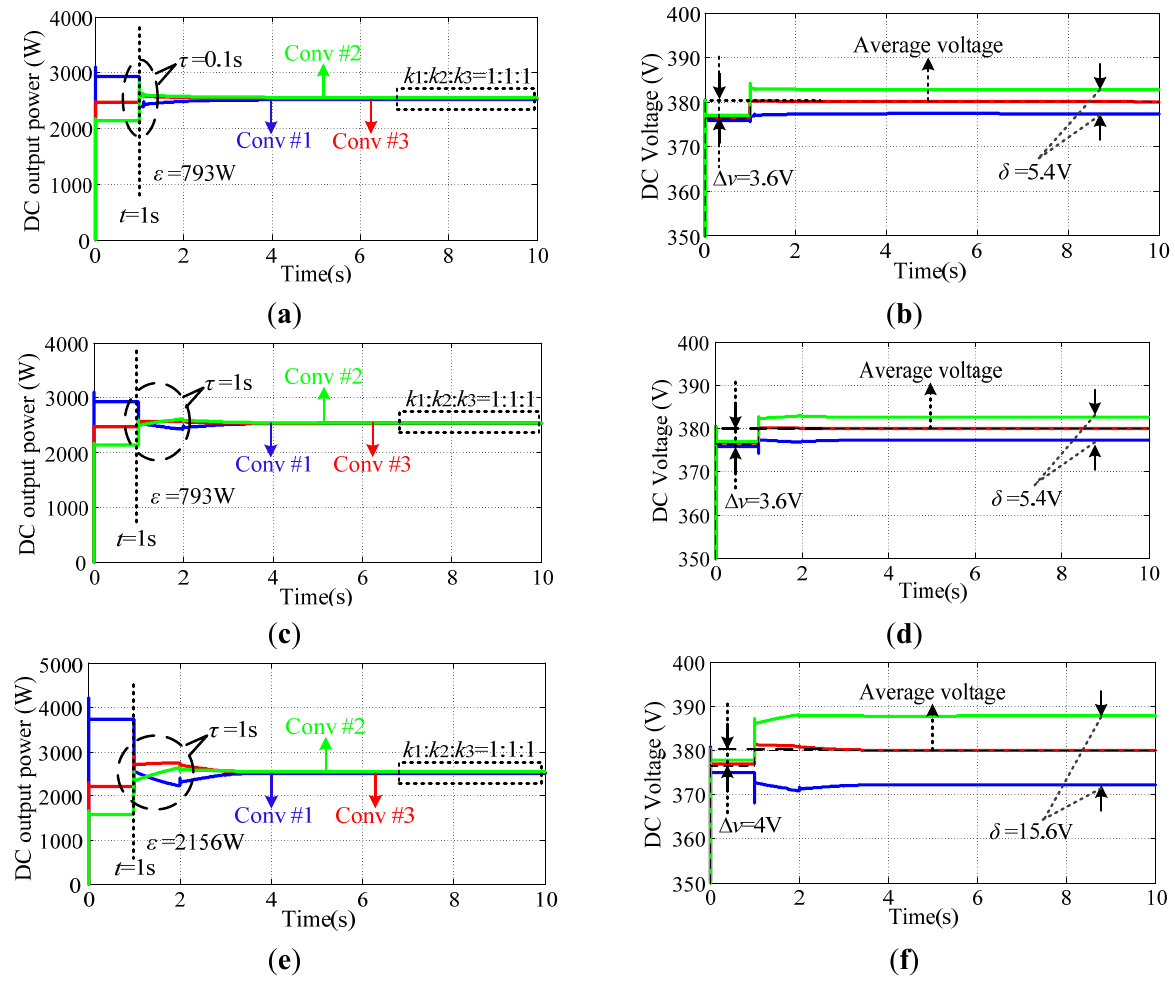
Figure 7. Transient responses for radial configuration in the DC microgrid. ( a ) Case 4, Power sharing accuracy; ( b ) Case 4, Voltage restoration; ( c ) Case 5, Power sharing accuracy; ( d ) Case 5, Voltage restoration; ( e ) Case 6, Power sharing accuracy; ( f ) Case 6, Voltage